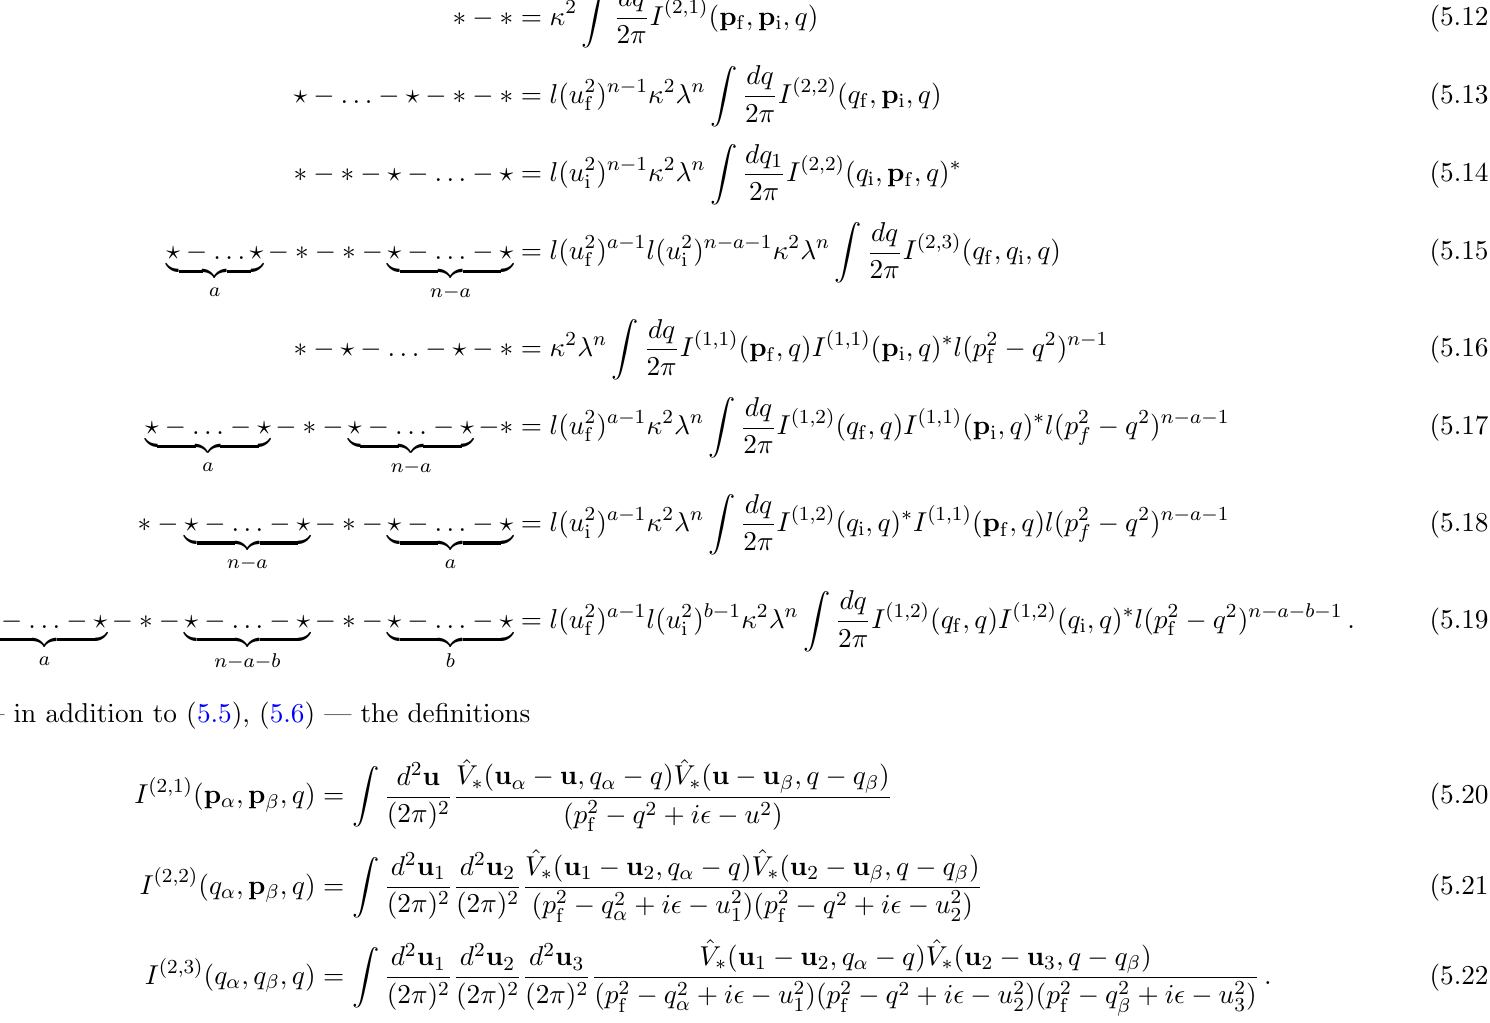
Table 1 . Expressions for all 8 types of diagrams appearing at order (cid:20) 2 . Only the diagrams in the box can lead to